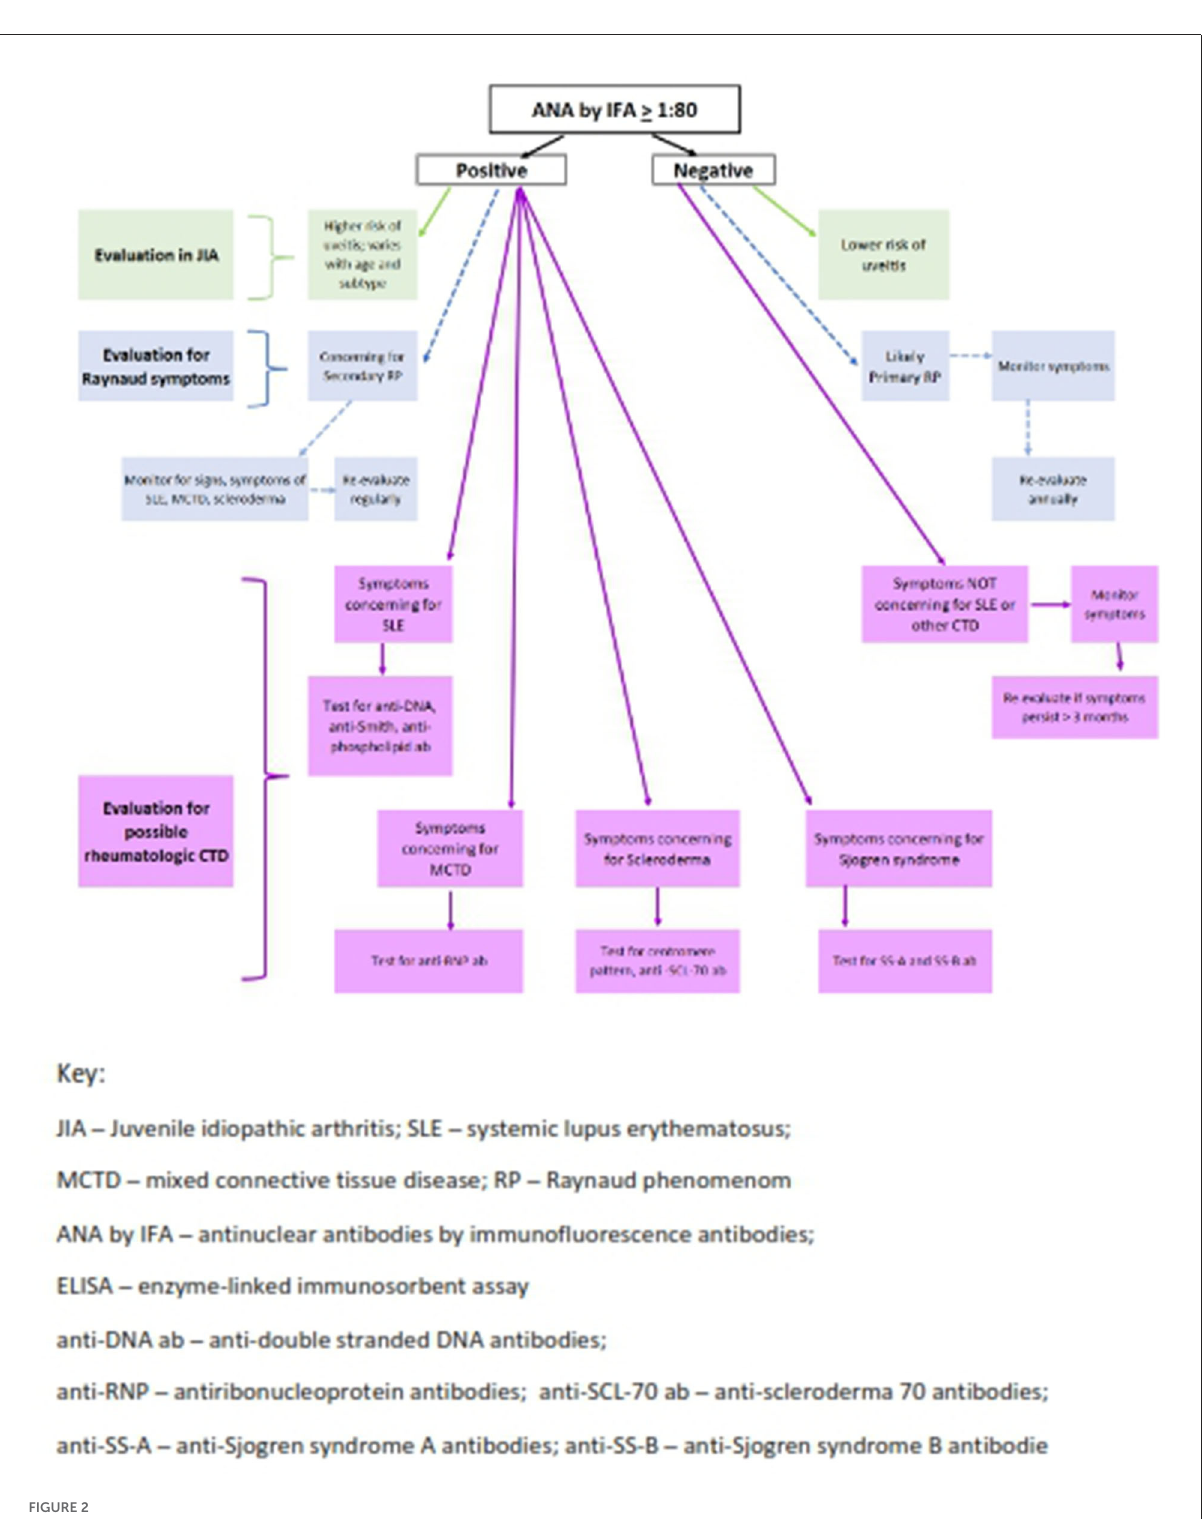
FIGURE2 Algorithm for ANA testing in pediatric rheumatology. Two-step testing: ANA must be tested by IFA and subsequent antibodies can be tested by ELISA and/or Multiplex